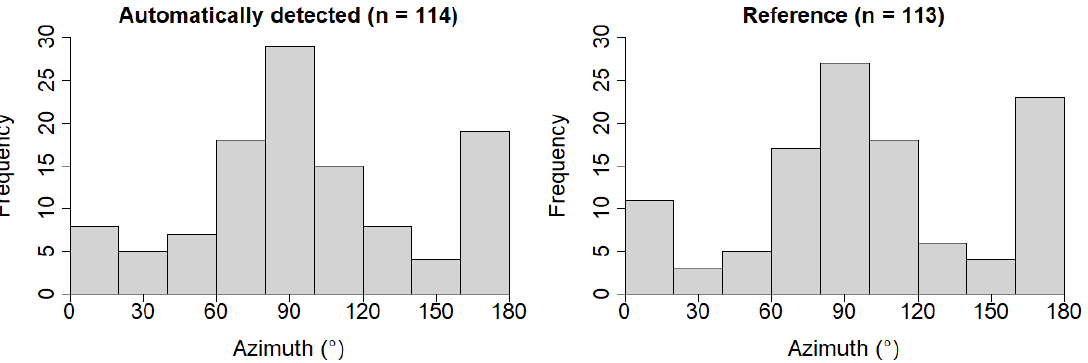
Figure 8. Kernel density estimation (KDE) of the stem centroid positions obtained via automatic detection and reference data on the exemplary sample site Frohn_02. Coordinates are in meters and in the “MGI/Austria GK M31” coordinate reference system (EPSG-code: 31258).